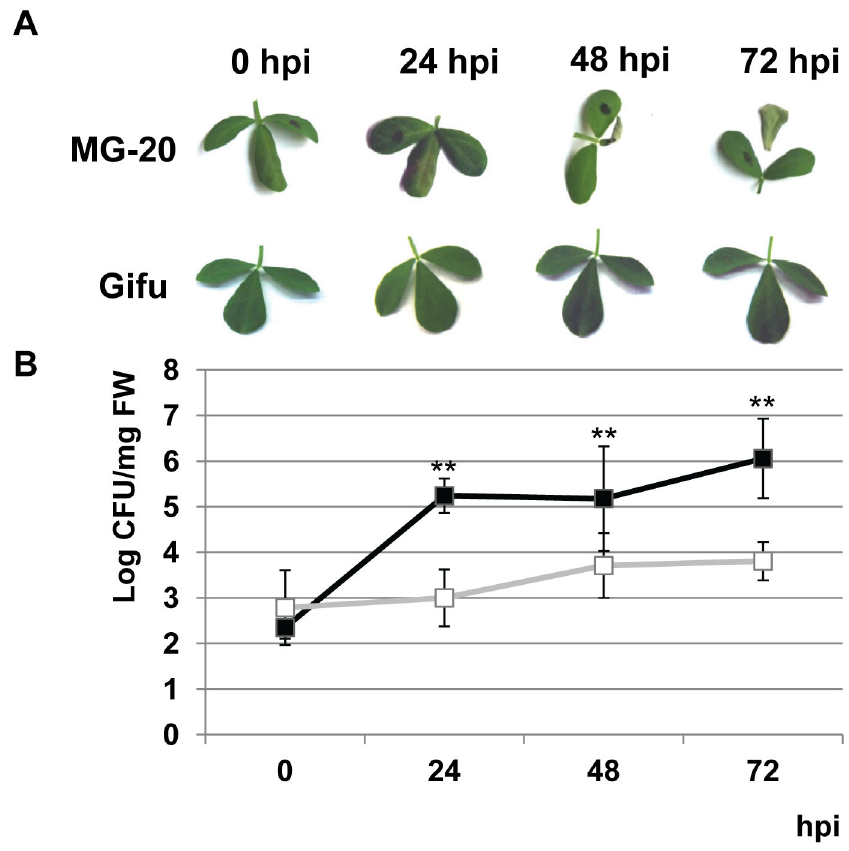
Figure 1. Differential phenotypes of L. japonicus ecotypes MG-20 and Gifu B-129 against Pto . A . Symptom development following bacterial infiltration in leaves from both ecotypes. Central leaflets were infiltrated using a needleless syringe as described in Materials and Methods. Eventually, lateral leaflets were marked with a black pen just for identification purposes. Pictures were taken immediately before inoculation and after a period of 24, 48 or 72 h. B. Measurement of Pto growth within MG-20 and Gifu B-129 infiltrated leaves. Data points represent the mean ± SD of three replicate experiments. Bacterial levels at 24, 48 and 72 hpi were statistical analyzed and compared against bacterial levels at 0 hpi, ** p<0.01. Black squares, MG-20; white squares,